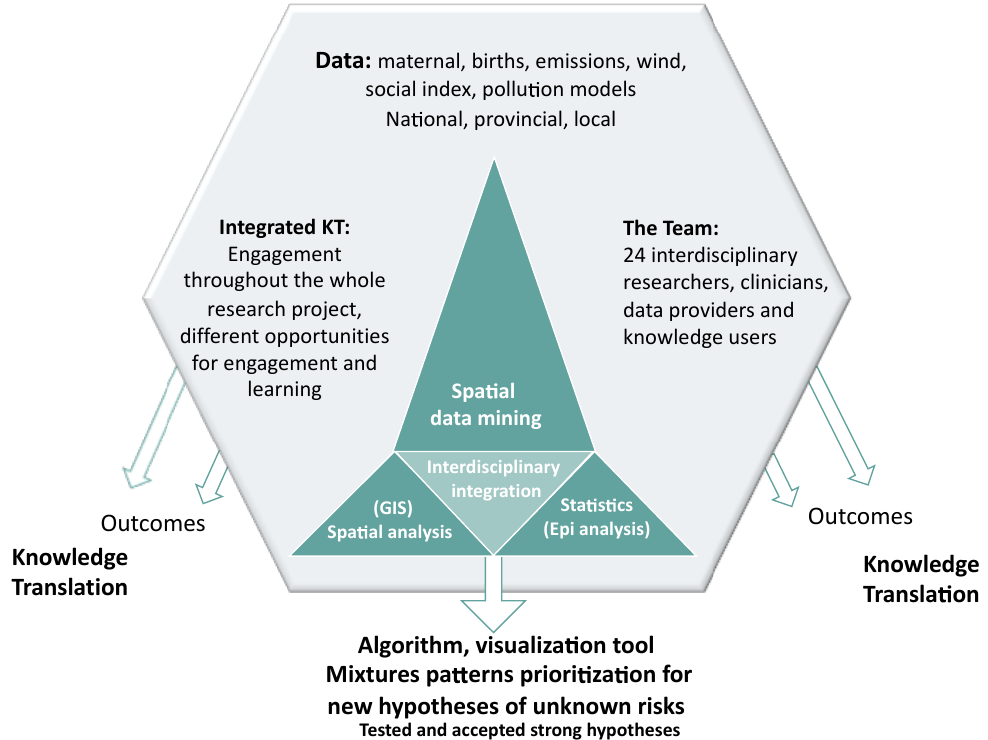
Figure 1. The DoMiNO Project research framework.